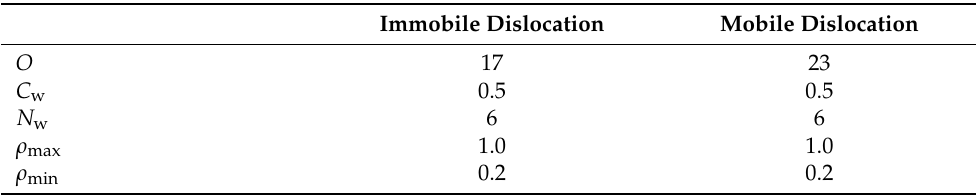
Table A1. Controlling parameter